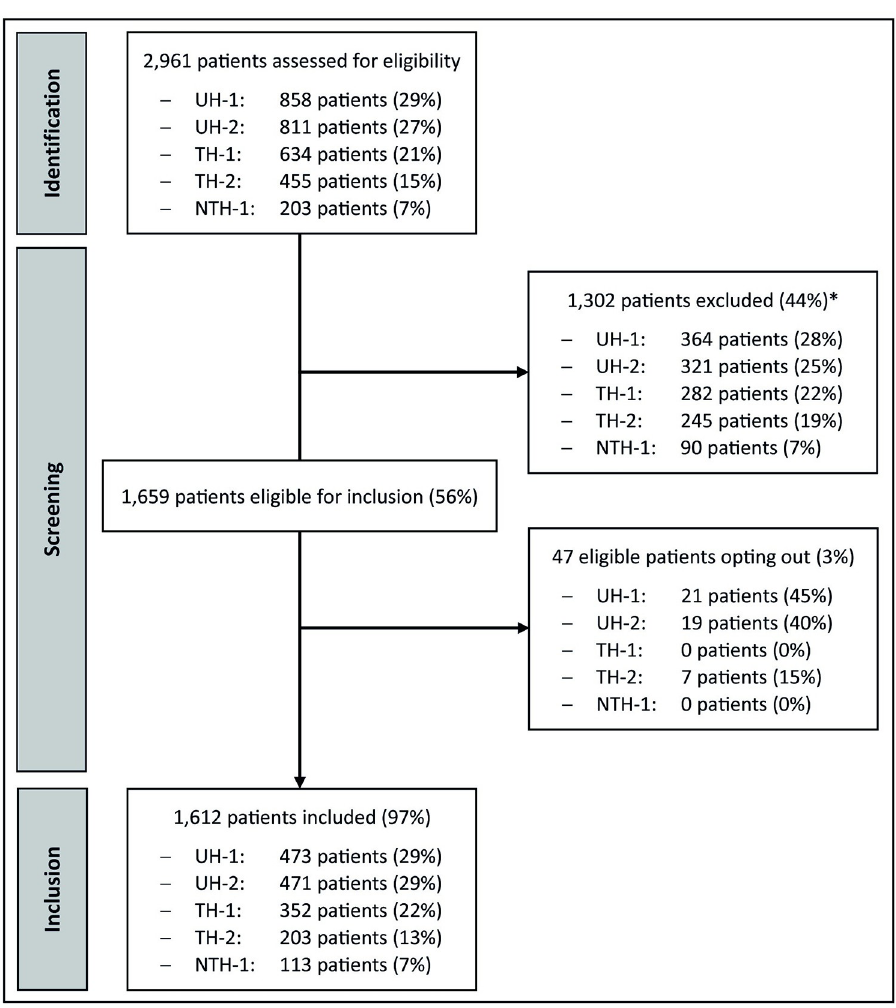
Fig 1. Flowchart of identification, screening and inclusion of data of patients diagnosed with malignant lymphoma in five hospitals in the region of Amsterdam, 2015–2020. � Reasons for exclusion were: no definitive lymphoma diagnosis (20%), lymphoma diagnosis and treatment prior completely took place before the study period (57%), diagnosed and treated for lymphoma all took place at another hospital (20%), and known HIV infection prior to lymphoma work-up and diagnosis (3%). NTH: Non-teaching hospital. TH: Teaching hospital. UH: University